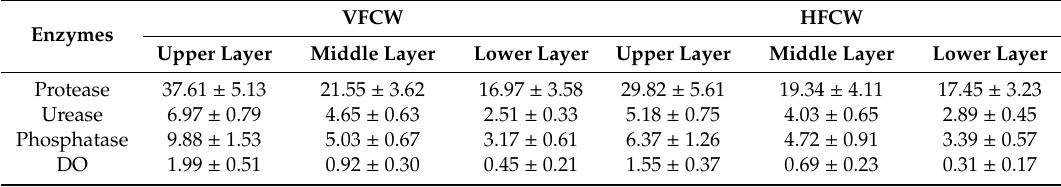
Table 1. Enzymatic activities in di ff erent substrate depths at the influent load of 200 L / day (units: U / g-substrate, mean ± SD, n =